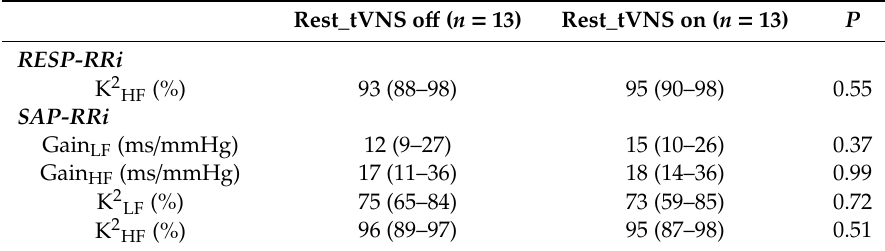
Table 3. Baseline measures of cardiorespiratory coupling and baroreflex control evaluated by transfer function